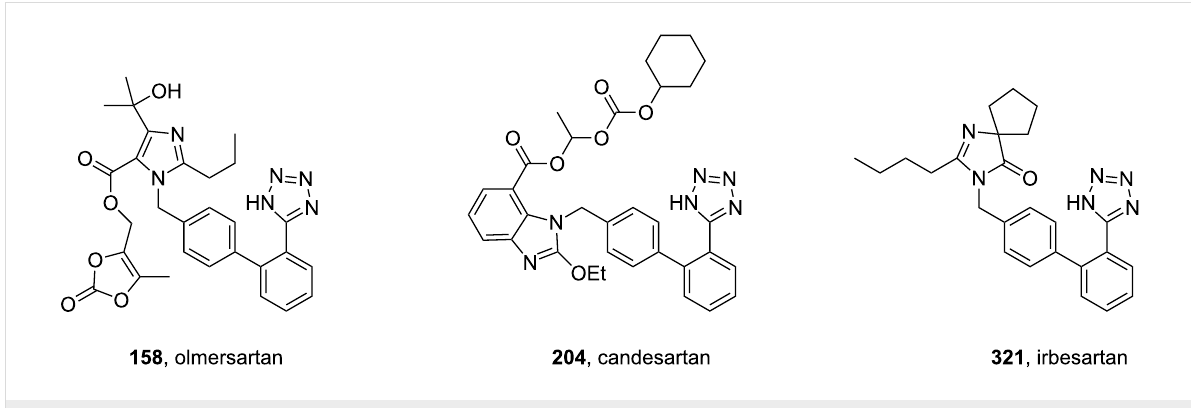
Figure 10: Structure of tetrazole containing olmesartan, candesartan and irbesartan.